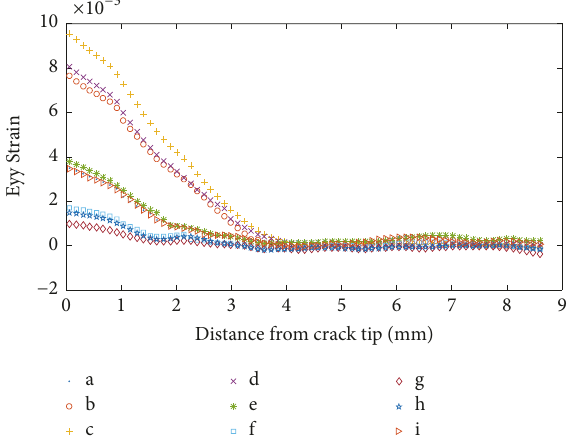
Figure 17: Strains of points from the crack tip at characteristic load values within one stress